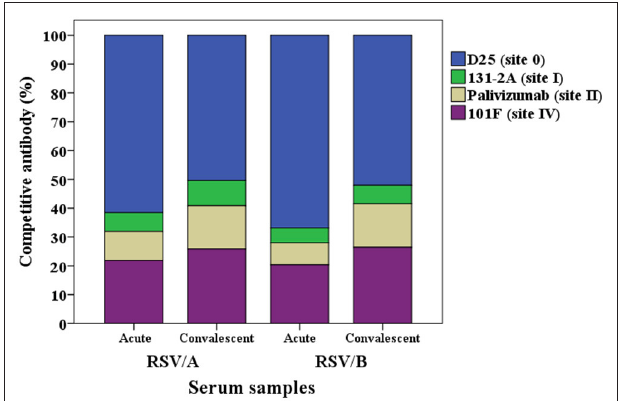
FIGURE 4 | Percentage of each RSV site-specific competitive antibody GMC ( µ g/mL) to the total GMC ( µ g/mL) for RSV/A and B infected HCT adults. GMC, geometric mean concentration. n = 40 in each competitive antibody assay.